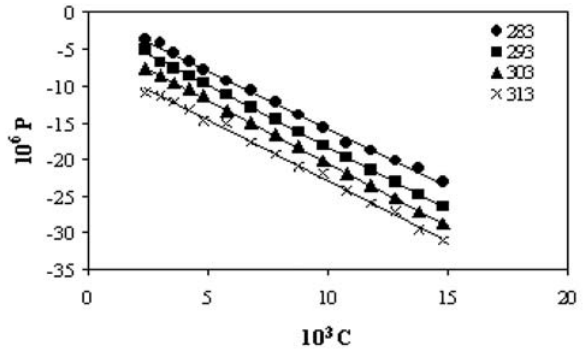
Figure 2. The Ketelaar plots of variable P vs. C for [ Co(cdaca- cen)(PBu ) ] + with Im at different temperatures (°C) in CH 3 where, P = C °